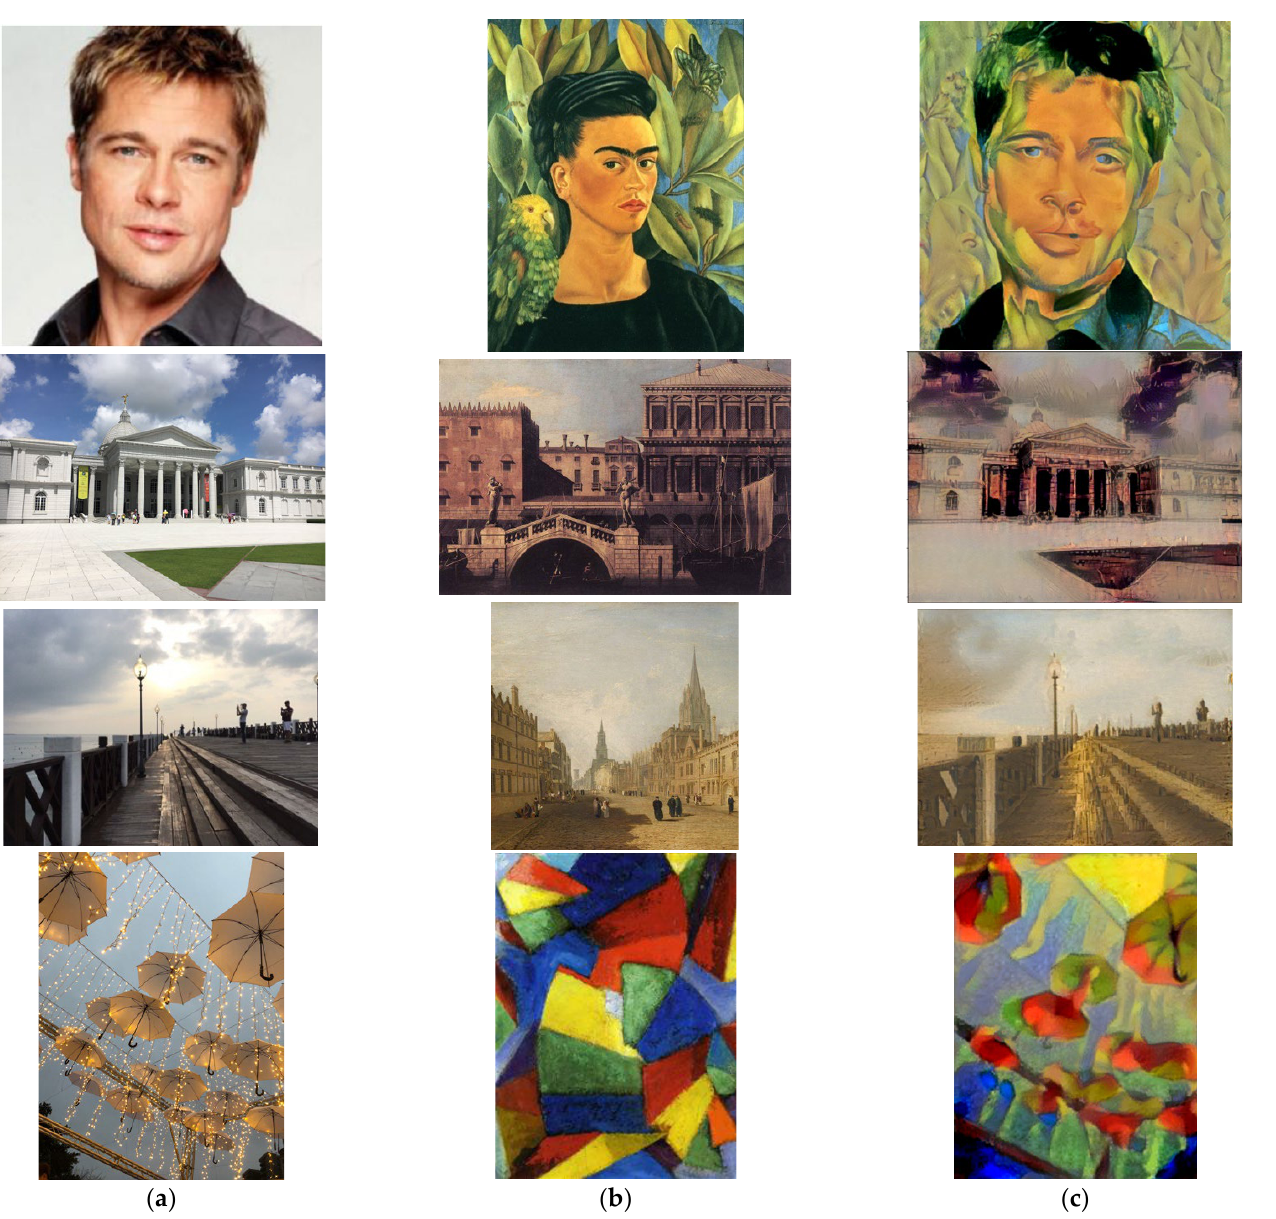
Figure 13. The results of the proposed method image transfer between a wildlife image and an ab- stract image. ( a ) Content image. From the MS-COCO dataset [26]. ( b ) Target image. From the WikiArt database [27]. ( c ) Color-transferred image with adaptive multilevel image color transfer.